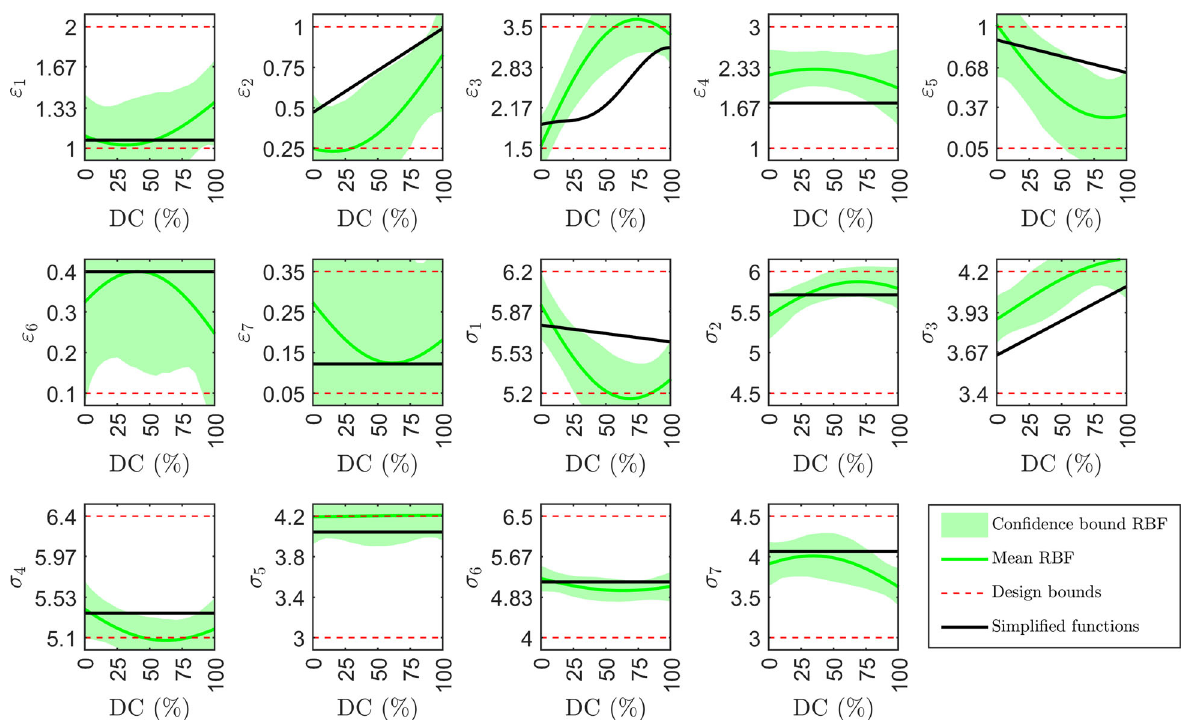
Fig. 4 Optimized DC-dependent functions of the non-bonded force fi eld parameters ½ ε i DC ð Þ ; σ i ð DC Þ(cid:2) . The green curves are RBFs yielding maximum goodness of fi t, see equation (1), between the AA and CG target properties. The green bands quantify the uncertainty of each parameter, which tells us how sensible the fi nal response of the model depending on the parameter. Where large uncertainties are present, e.g., in the ε 6 and ε 7 functions, we were able to modify the class of function of that parameter to either linear or constant without loss of accuracy of the model ’ s response, thus simplifying the parametrization. The black curves are obtained after simplifying the class of functions and minimizing the squared difference in the AA and CG model response. Note that once a new class of functions is chosen, the new function is not necessarily an approximation of the RBF for each individual parameter. The simpli fi ed formulation maintained a fair match 59 with the AA models with an average root mean squared percentage error (RMSPE) of 10%. We did not observe a noticeable loss of accuracy of the model compared to calibrations of much higher complexity, see Supplementary Figs. 7 and 9.